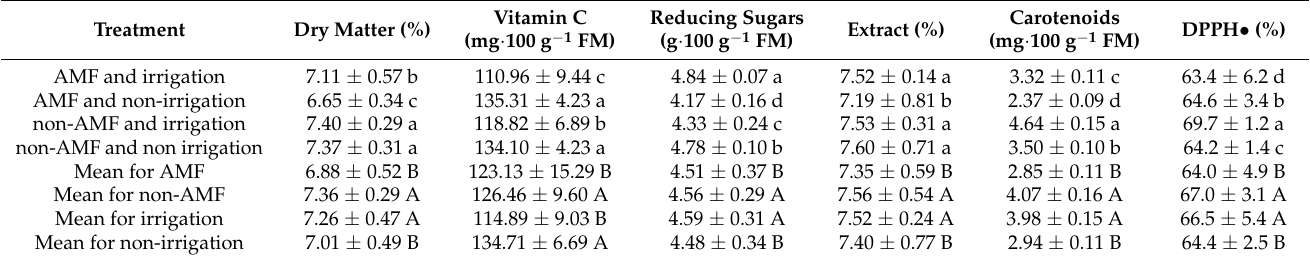
Table 3. Selected fruit quality parameters of bell pepper grown with or without mycorrhizal inoculation and irrigation (mean for 2016–2018).